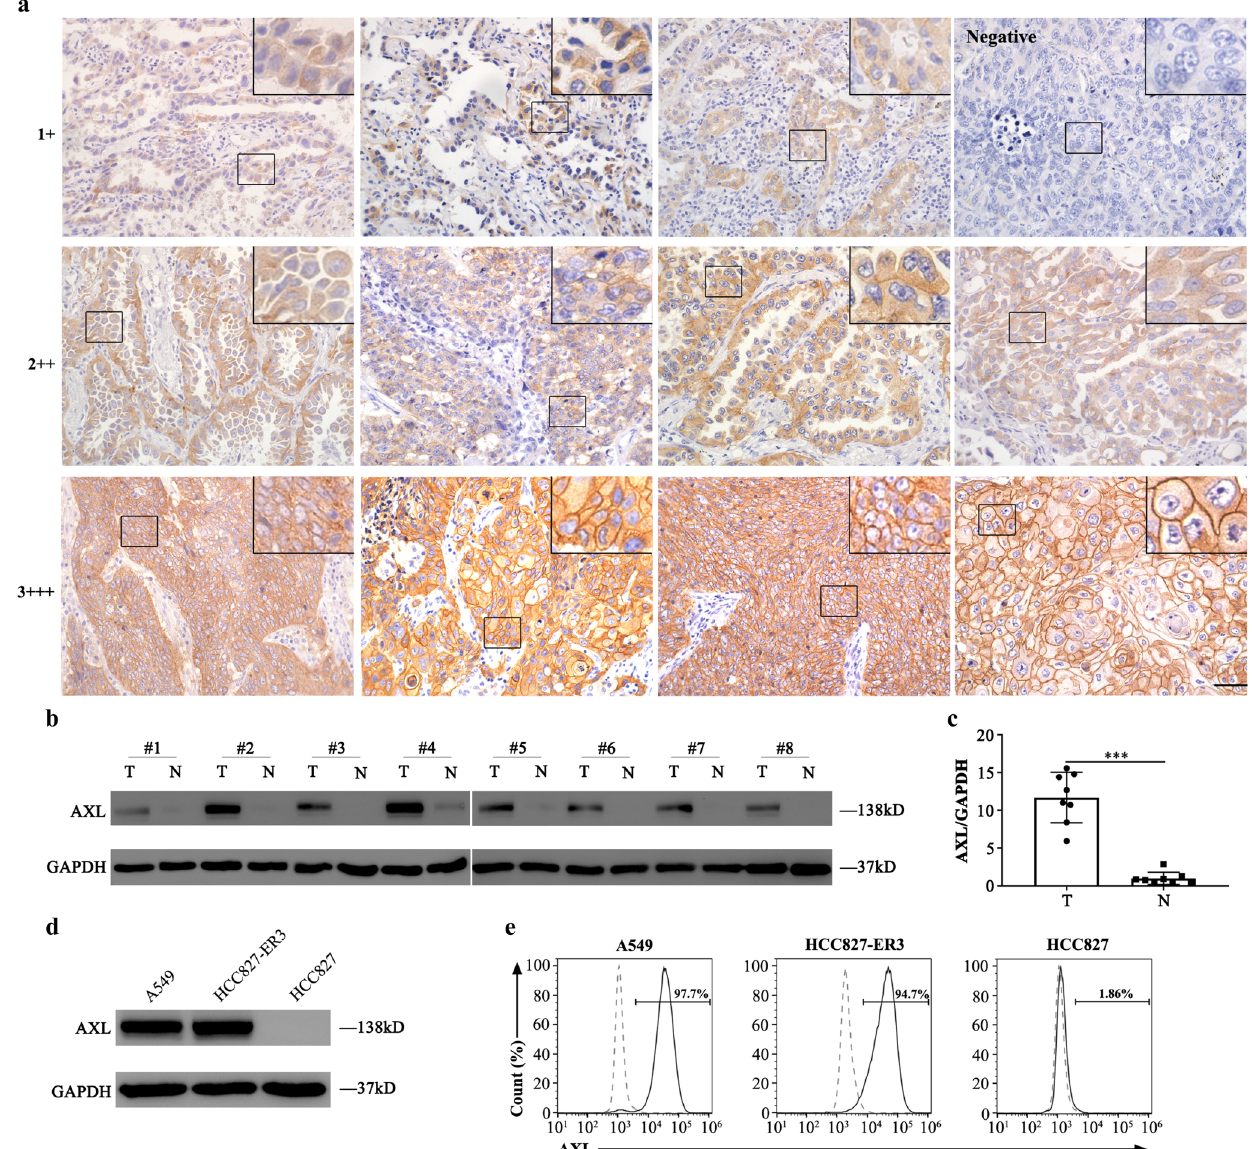
Fig.1|AXLexpressioninhumannormalandNSCLCtissuesandlungcancercell lines. a Detection of AXL expression in NSCLC samples by IHC. Representative images (magni fi cation × 400) are shown ( n =90). Scale bar represents 100 μ m. b , c Detectionandquanti fi cationofAXLexpressionbywesternblottingineightpairs of EGFR-TKI resistant NSCLC tissues (T) and adjacent normal lung tissues (N). Each